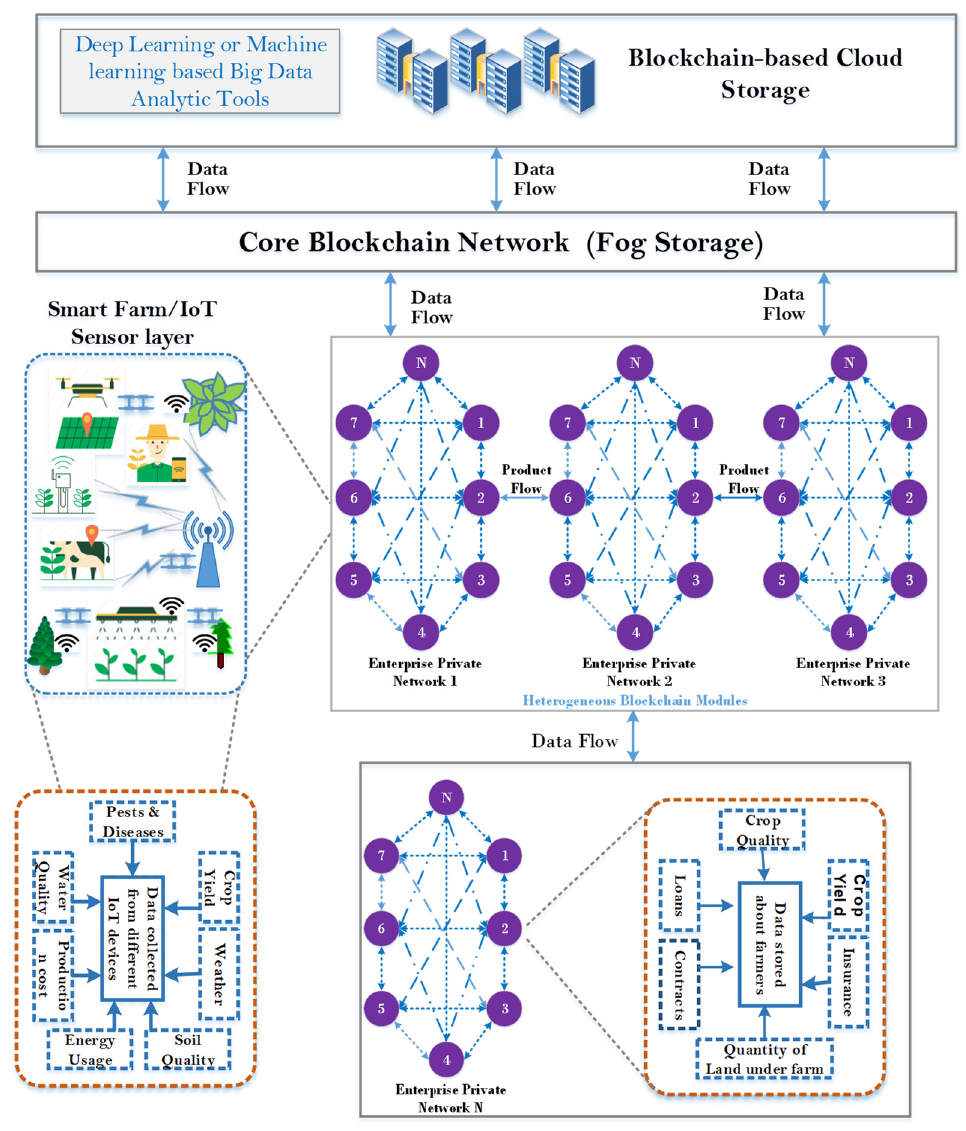
Figure 5. Proposed new Agri-SCM-BIoT Architecture .